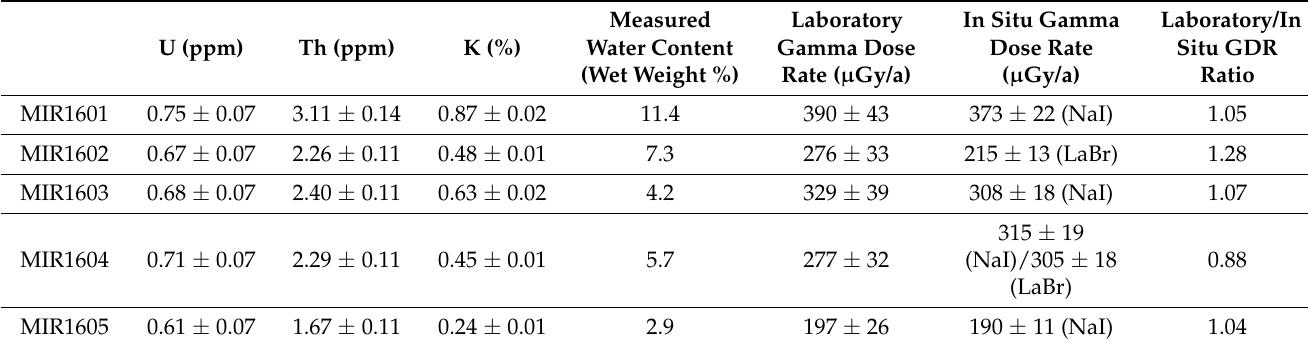
Table 4. Radioelement concentrations measured from raw sediment by ICP-MS analysis. Laboratory gamma dose rate was calculated using dose rate conversion factors from [57], measured water content, and radioelement concentrations. In situ gamma dose rates are based on threshold approach. Probe employed indicated in parentheses.